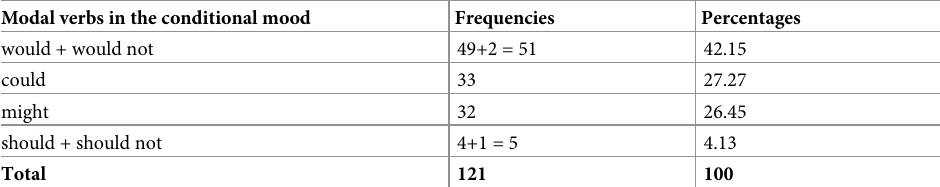
Table 14. Frequencies and percentages of modal verbs in the conditional mood. Modal verbs in the conditional mood